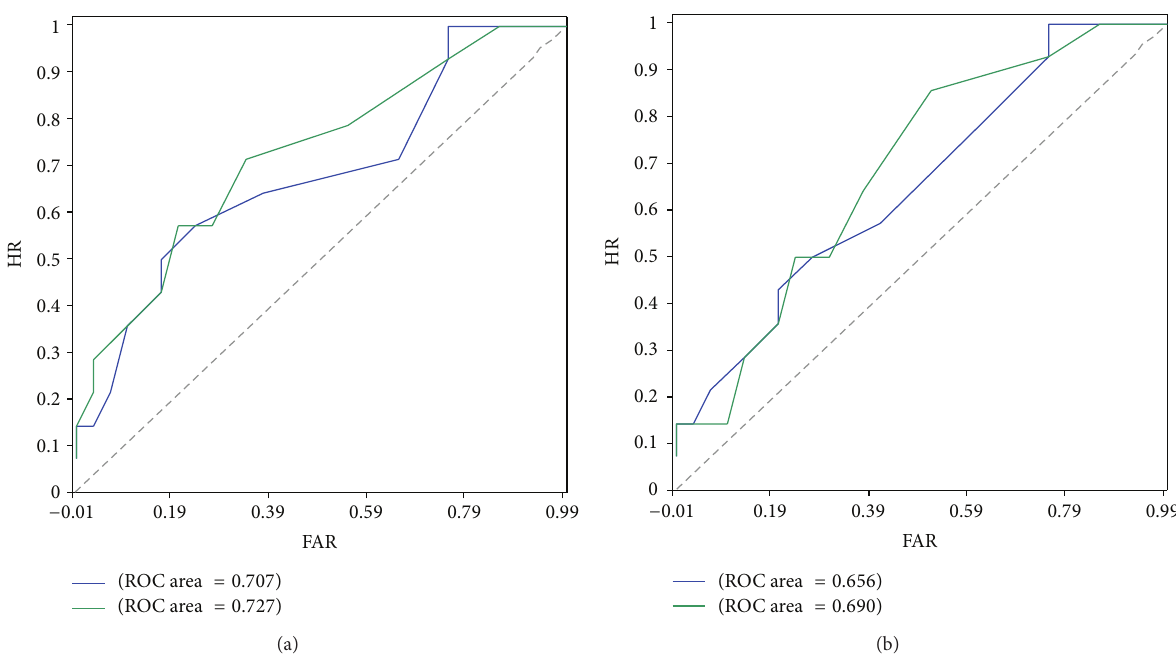
Figure 1: ROC curves of February (3–5) forecasts for UT categories using the DEMETER-3 ensemble over northern Pakistan for the period of 1959–2001 and validated against (a) observations and (b) ERA-40. Blue and green lines represent uncorrected and bias-corrected skills, respectively.